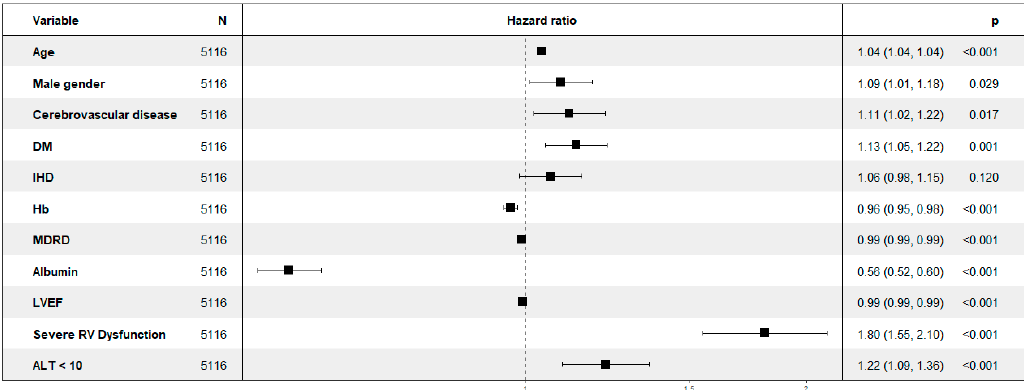
Figure 3. Forest plot depicting multivariate analysis for mortality.